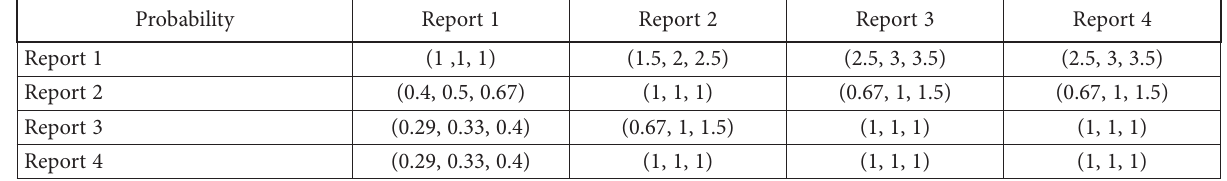
Table 4. Criteria comparison of received reports in Airport Services